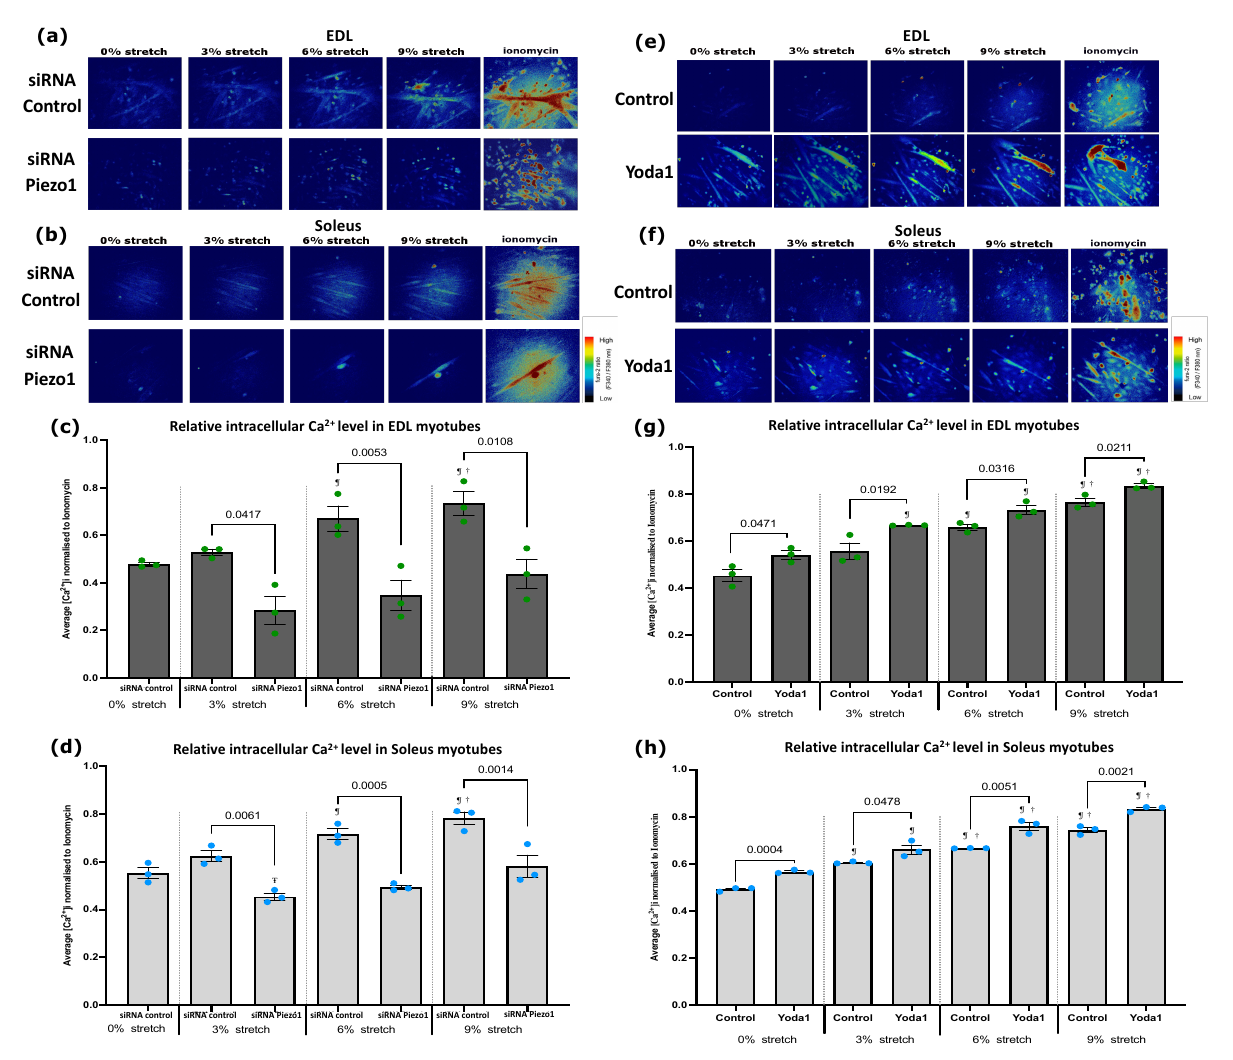
Figure 2. Modulation of Piezo1 alters stretch-mediated increase of intracellular Ca 2+ in myotubes. ( a , b ) Representative images of intracellular Ca 2+ imaging in EDL and SOL-derived myotubes. Myoblasts were transfected with 10 nM of either control-siRNA (top panels) or Piezo1- siRNA (bottom panels). After overnight incubation, cells were incubated for a further 72 h in differentiation medium. Fura 2-AM was administered to myotubes followed by a 30-min incubation time. Stretch was then applied at 3% (0.3 mm), 6% (0.6 mm) and 9% (0.9 mm) for 1 min followed by a 1-min resting period in between. Ionomycin at 5 µM was then applied. Side vertical bar shows Fura 2-AM ratio emittance from low to high. ( c , d ) Average changes in the intracellular Ca 2+ level ([Ca 2+ ]i) calculated by difference between base and peak pixel value normalised to ionomycin. ( e , f ) Representative images of Ca 2+ imaging in EDL and SOL-derived myotubes. Fura 2-AM was administered to myotubes followed by a 30-min incubation time. Stretch was then applied at 3% (0.3 mm), 6% (0.6 mm), and 9% (0.9 mm) for 1 min followed by a 1-min resting period in between. During the initial 0% stretch timepoint, Yoda1 cohorts were administered with 30 µM of the agonist before being subjected to stretch (0% Yoda1 pictures were taken within 10–20 s after agonist administration). Ionomycin at 5 µM was then applied. Side vertical bar shows Fura 2-AM ratio emittance from low to high. ( g , h ) Average changes in the intracellular Ca 2+ level ([Ca 2+ ]i), difference between base and peak pixel value normalised to ionomycin. Data are mean ± SEM from three experiments ( n = 3 mice). p values are annotated above graphs showing significance compared to control at each stretch condition. ¶: Significant difference at p < 0.05 compared to 0% stretch counterparts. †: Significant difference at p < 0.05 compared to 3% stretch counterparts. Ŧ: Significant difference at p < 0.05 compared to 9% stretch in Piezo1 -siRNA conditions using one-way ANOVA followed by the Tukey–Kramer post-hoc.